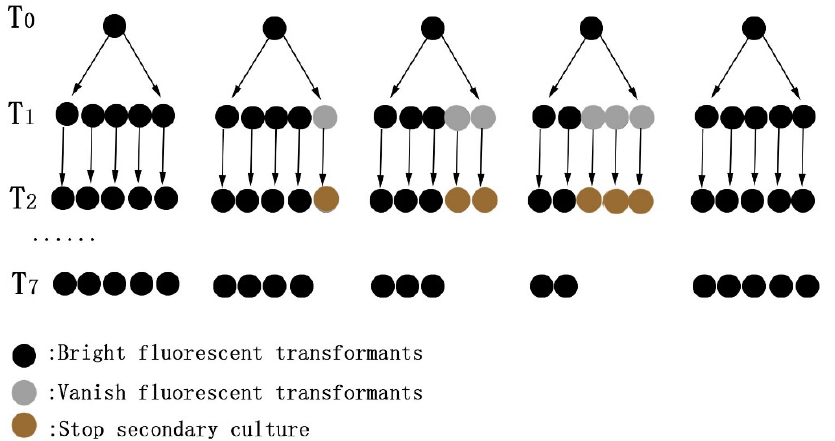
Figure 1. Stability of the fluorescent transformants of CA-HMR1. Five transformants (T0) with bright fluorescence expression were selected randomly by resistance screening and fluorescence microscopy. Sub-cultured to generate progeny transformants (T1), until the T7 generation. The fluorescence of each transformant was observed to analyze the fluorescence stability of the trans- formants.